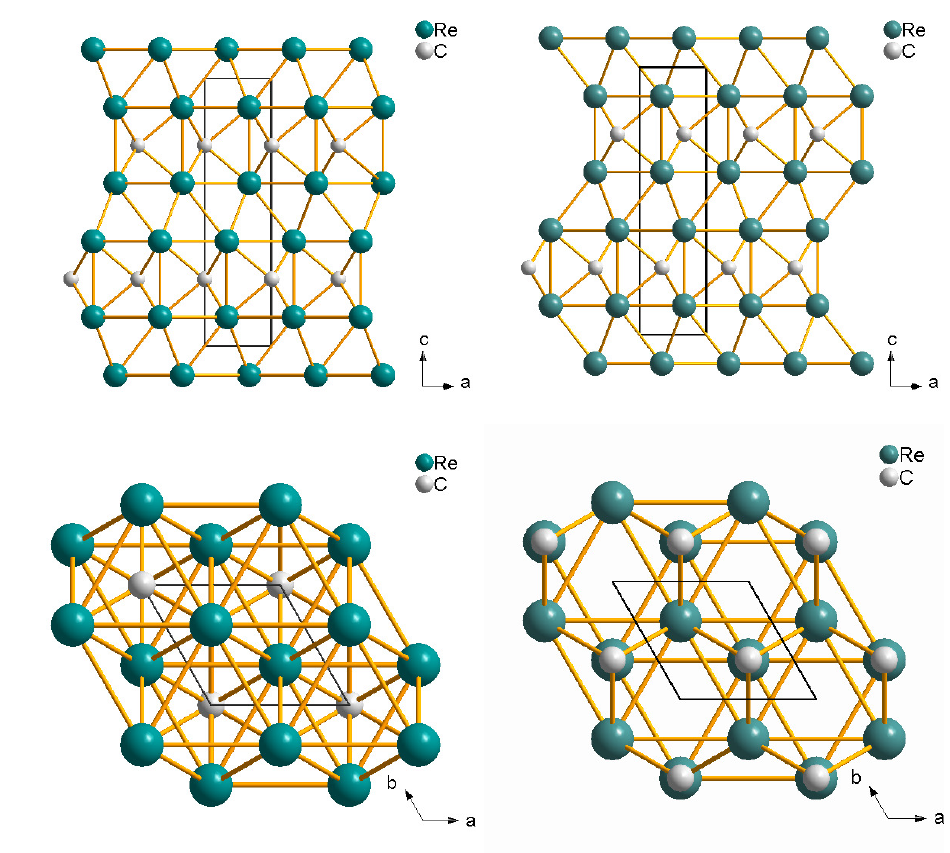
Figure 15. Crystal structure of Re Juarez-Arellano et al. [62] (left) and of anti-ReB the different carbon